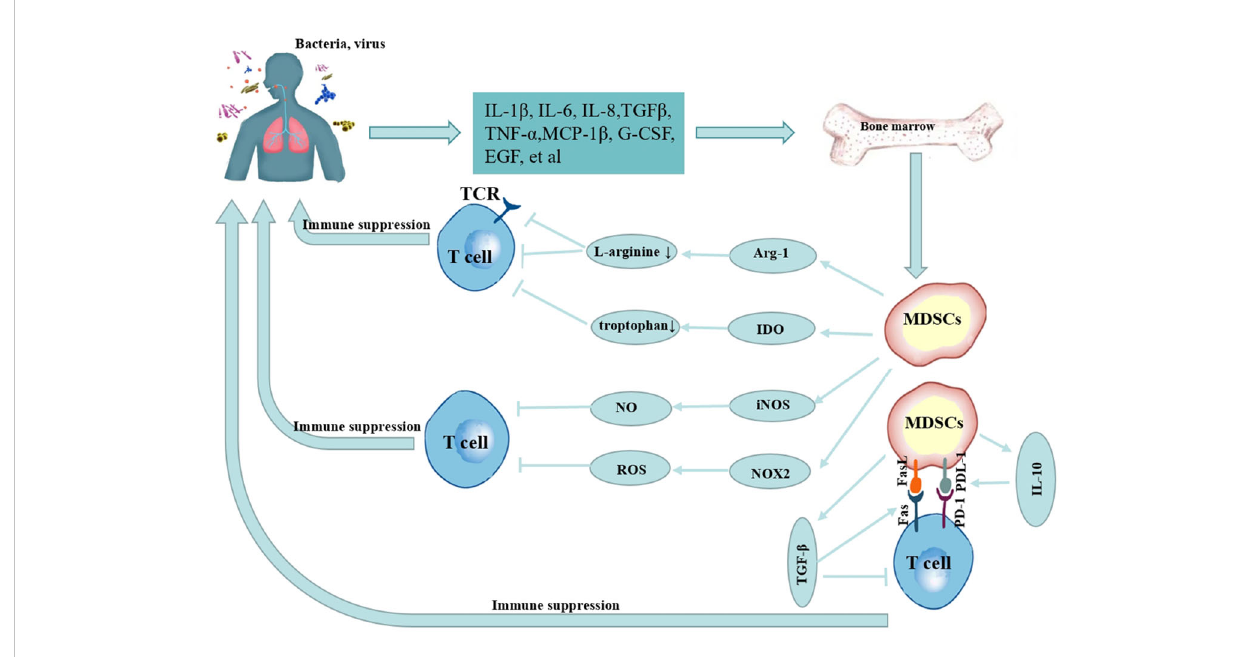
FIGURE 1 Mechanism of MDSCs in infectious lung diseases.